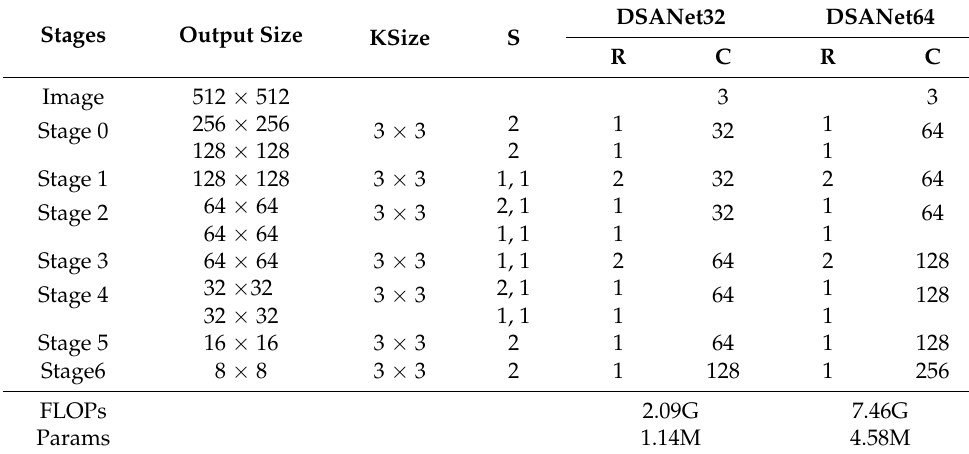
Table 2. Detailed Architecture of the DSANet